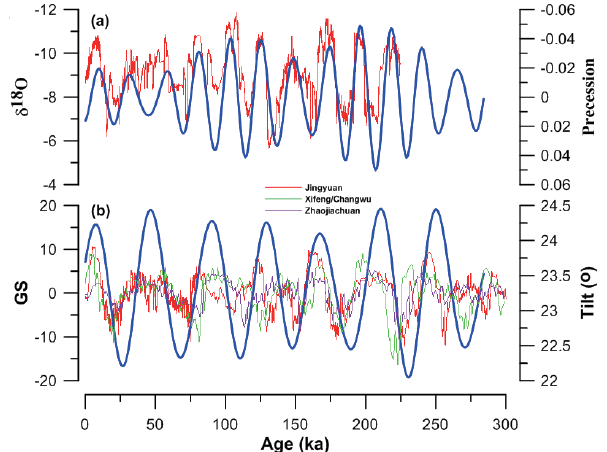
Fig. 3. Simulated time-dependent responses of East Asian summer and winter monsoons during the past 284ka. The monsoon indices are defined as the averaged sea-level pressure for the Asian Low region (25–40 ◦ N, 70–110 ◦ E) in boreal summer (JJA) and for the Siberian High region (30–70 ◦ N, 60–130 ◦ E) in boreal winter (DJF), respectively. The components with periods of less than 10ka have been filtered